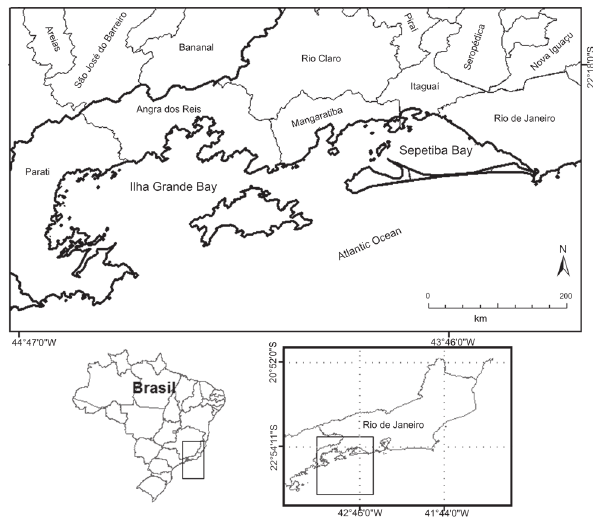
Figure 1. Map of study area, the great complex estuarine formed by Ilha Grande Bay and Sepetiba Bay, southeastern